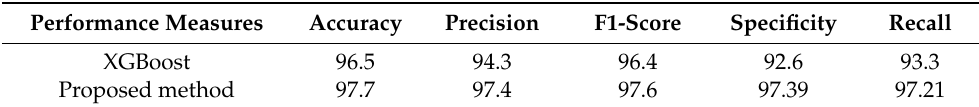
Table 7. Comparison of the suggested model with the XGBoost